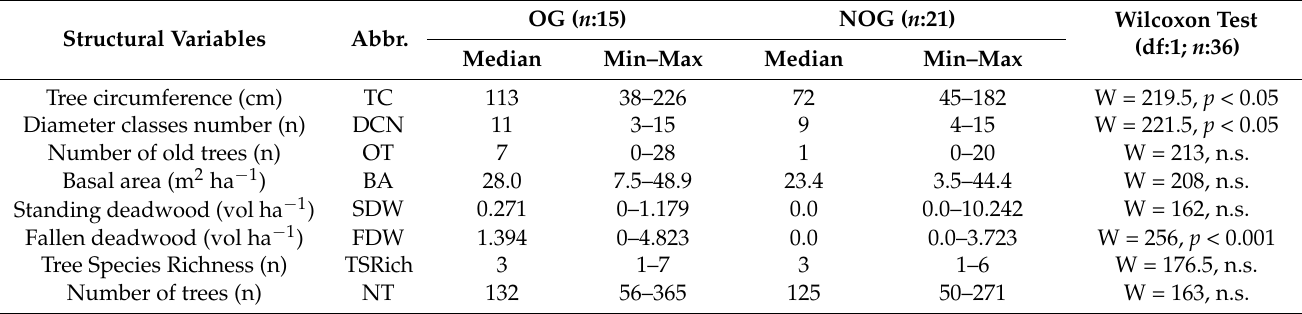
Table 1. Descriptive statistics of the structural variables included in the models. Results of the Wilcoxon test performed for the two forest types are also reported. n.s.: not significant ( p > 0.05). Structural